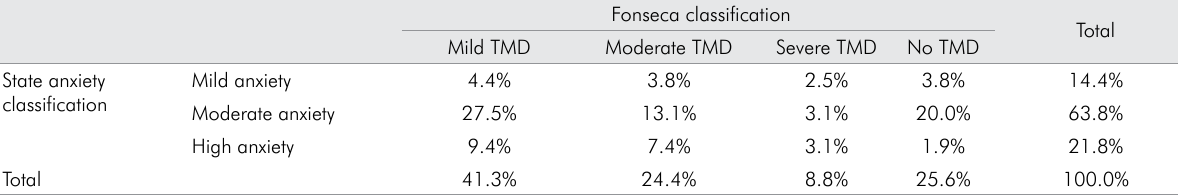
Table 3. Association between Fonseca classification and state anxiety